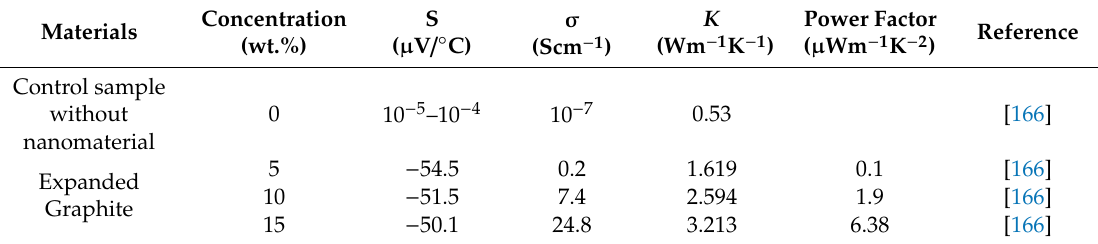
Figure 25. Estimation of ( a ) electrical conductivity, ( b ) seebeck coefficient and ( c ) power factor of graphene cement composite. Reproduced with permission from [164], Elsevier, 2019. Table 4. Thermoelectrical properties of graphene based cement